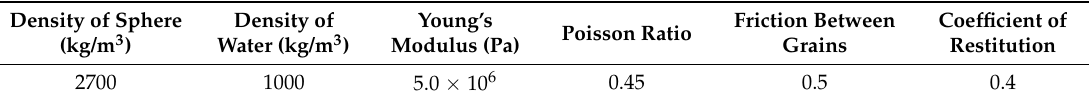
Table 1. Parameters for numerical